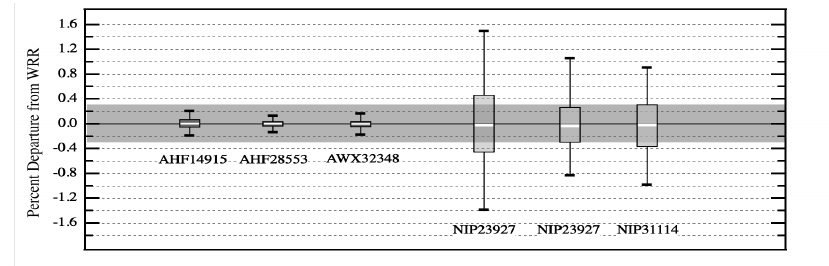
Figure 2. Box and whisker plots from IPC-XII Results for three North American Region cavity type pyrheliometers and a group of three working class pyrheliometers typically used at monitoring sites in WMO regions. Whisker caps are at 2nd and 98th percentiles. Box boundaries at 25th and 75th percentiles and median. Shaded band is stated uncertainty of the WRR. Precision losses in WRR ratios can range from factors of ten up to forty [7].